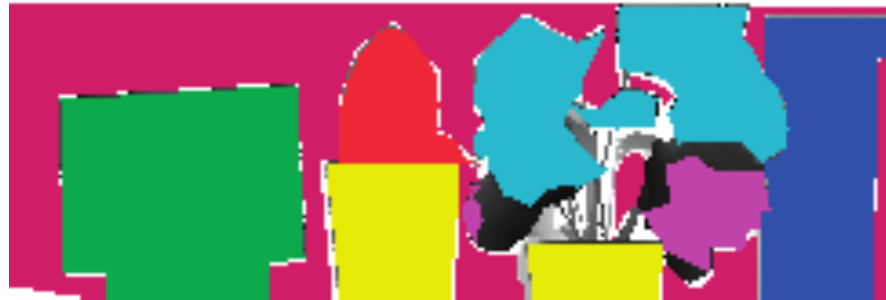
Figure 4. Manual delineation of the validation dataset for each prior class with different